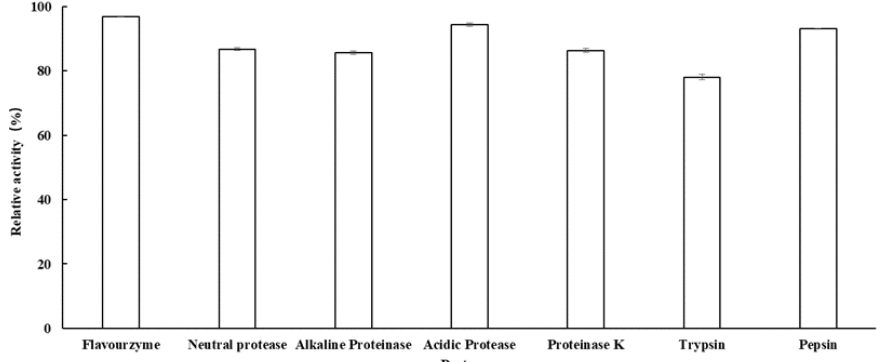
Figure 5. The ability of β -D-fructofuranosidase AlFFase3 to resist various proteases.